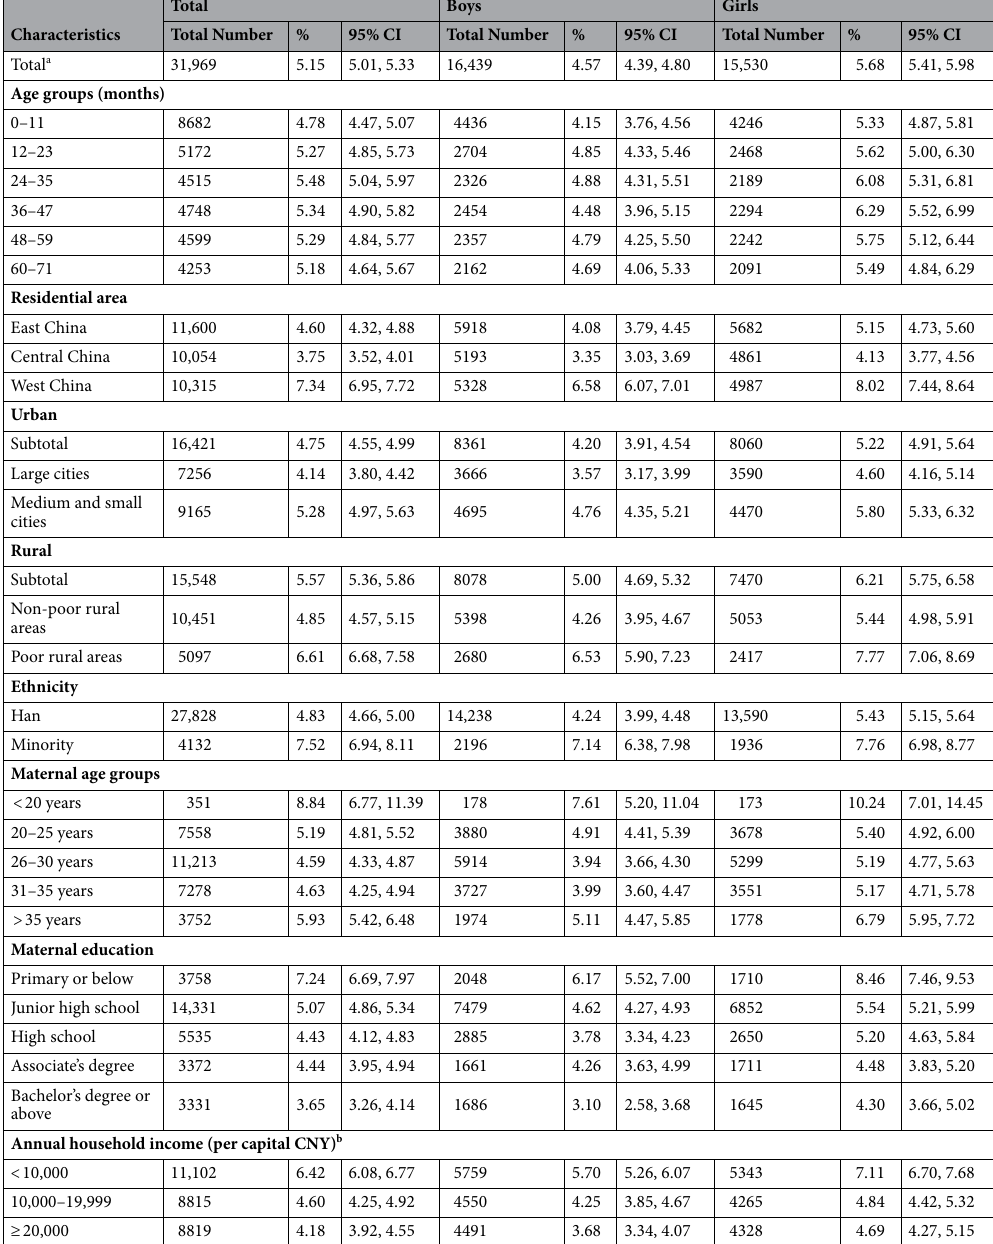
Table 2. The prevalence of LBW among Chinese children under 6 years in 2013. a Information on preterm was missing for 307 subjects. b 3251 of subjects refused to answer the question about annual household